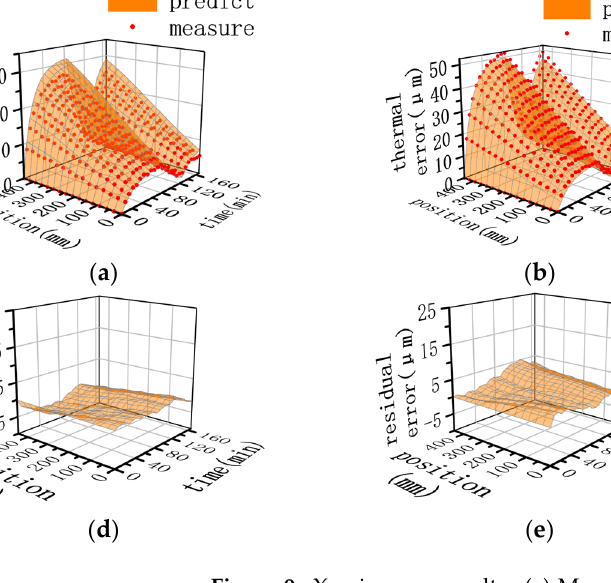
Figure 9. X-axis error results. ( a ) Measured thermal error in condition 1. ( b ) Measured thermal error in condition 2. ( c ) Measured thermal error in condition 3. ( d ) Residual error in condition 1. ( e ) Residual error in condition 2. ( f ) Residual error in condition 3.